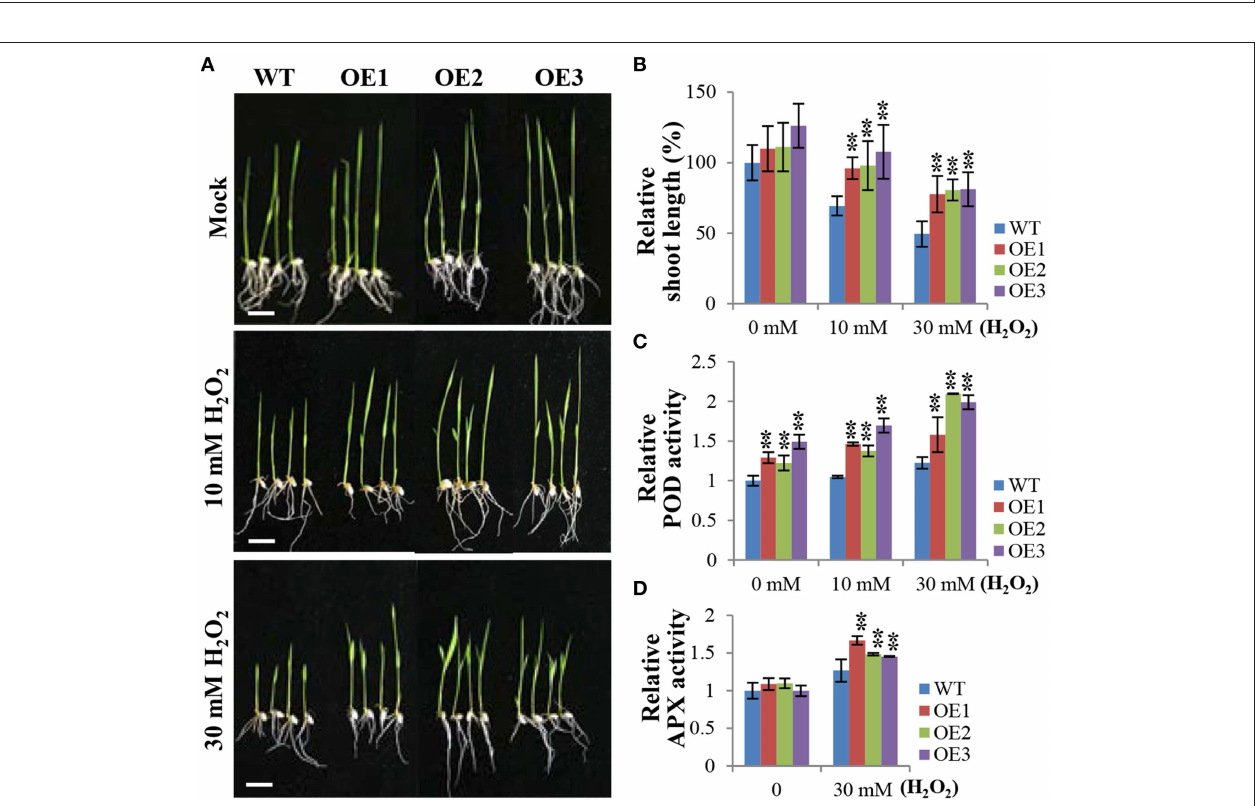
FIGURE 6 | OsCYP21-4 OE plants exhibit enhanced tolerance to H 2 O 2 treatment and increased peroxidase activity. (A) Comparison of rice seedlings under H 2 O 2 treatment. Transgenic plants (OE) and wild-type (WT) seeds were germinated on MS medium with or without hygromycin (50mg/L), respectively, and after 3 days, they were transferred to distilled water containing 10mM or 30mM H 2 O 2 and grown for 5 days. (B) Relative shoot lengths of transgenic and WT control seedlings. (C,D) Relative peroxidase and ascorbate peroxidase activities in WT and OsCYP21-4 OE plants. Error bars represent SE of three biological replicates. Asterisks indicate significant differences between WT control and OsCYP21-4 OE transgenic plants (Student’s t -test: ** p < 0.05 ). Bars =